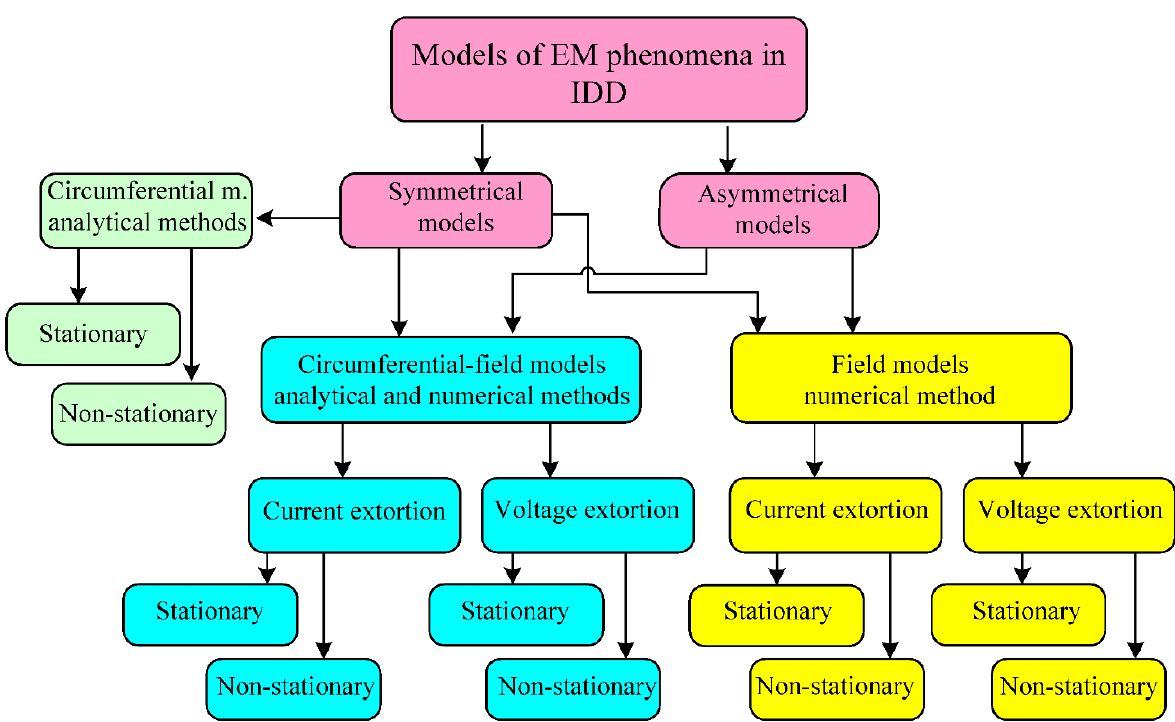
Figure 8. Ways of modeling electromagnetic phenomena in the induction – dynamic drive.